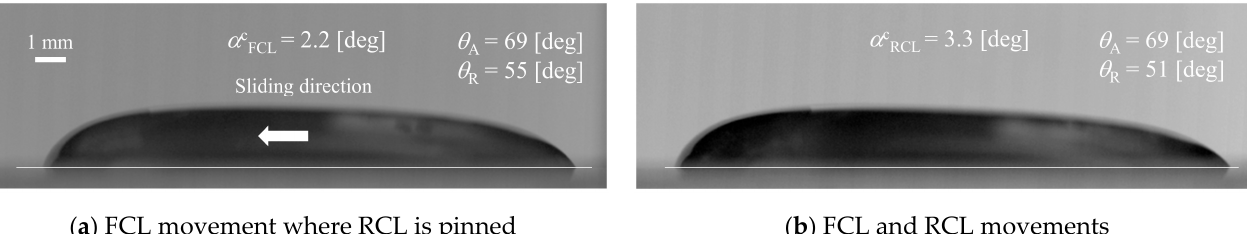
Figure 11. Images for onset of each contact line (CL) of the 39.3 wt% droplet (400 μ L).